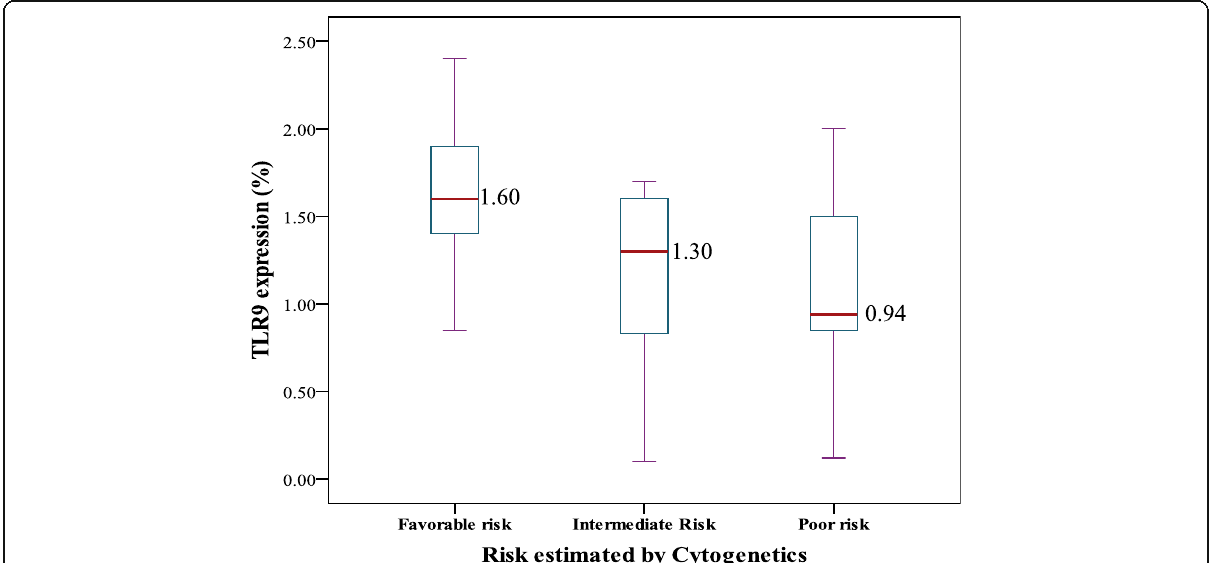
Fig. 3 The median TLR9 in regard to the risk estimated by cytogenetic analysis of the studied AML patients